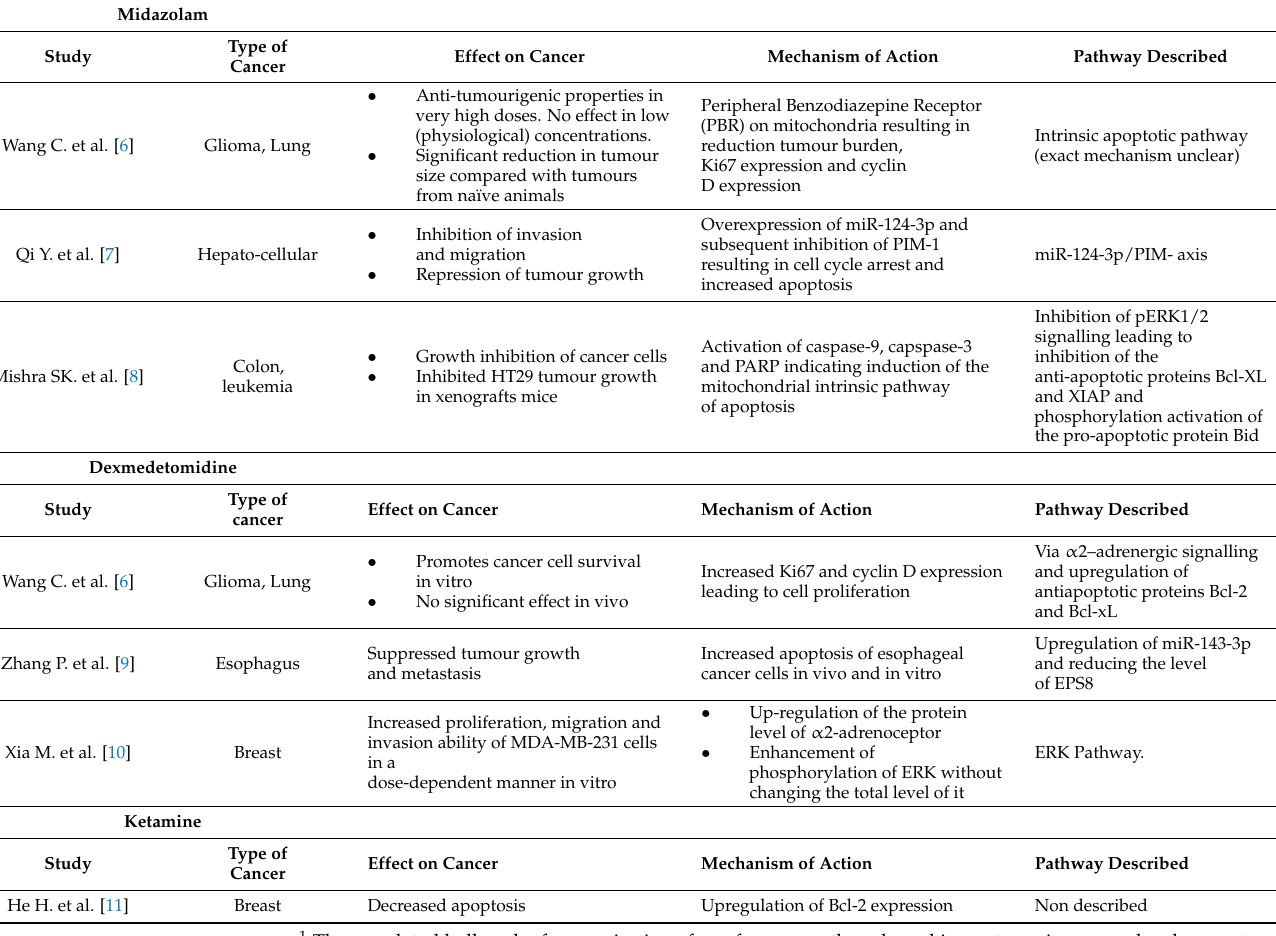
Table 1. Studies describing the direct effects of midazolam, dexmedetomidine, and ketamine on cancer cells, the associated mechanisms of action and their respective pathways 1